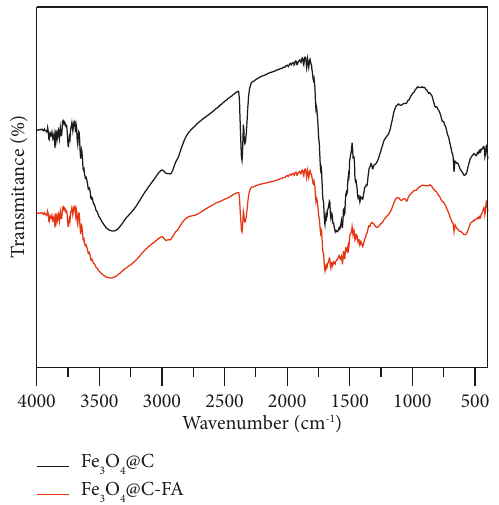
3 O 4 NPs at different scale bars.